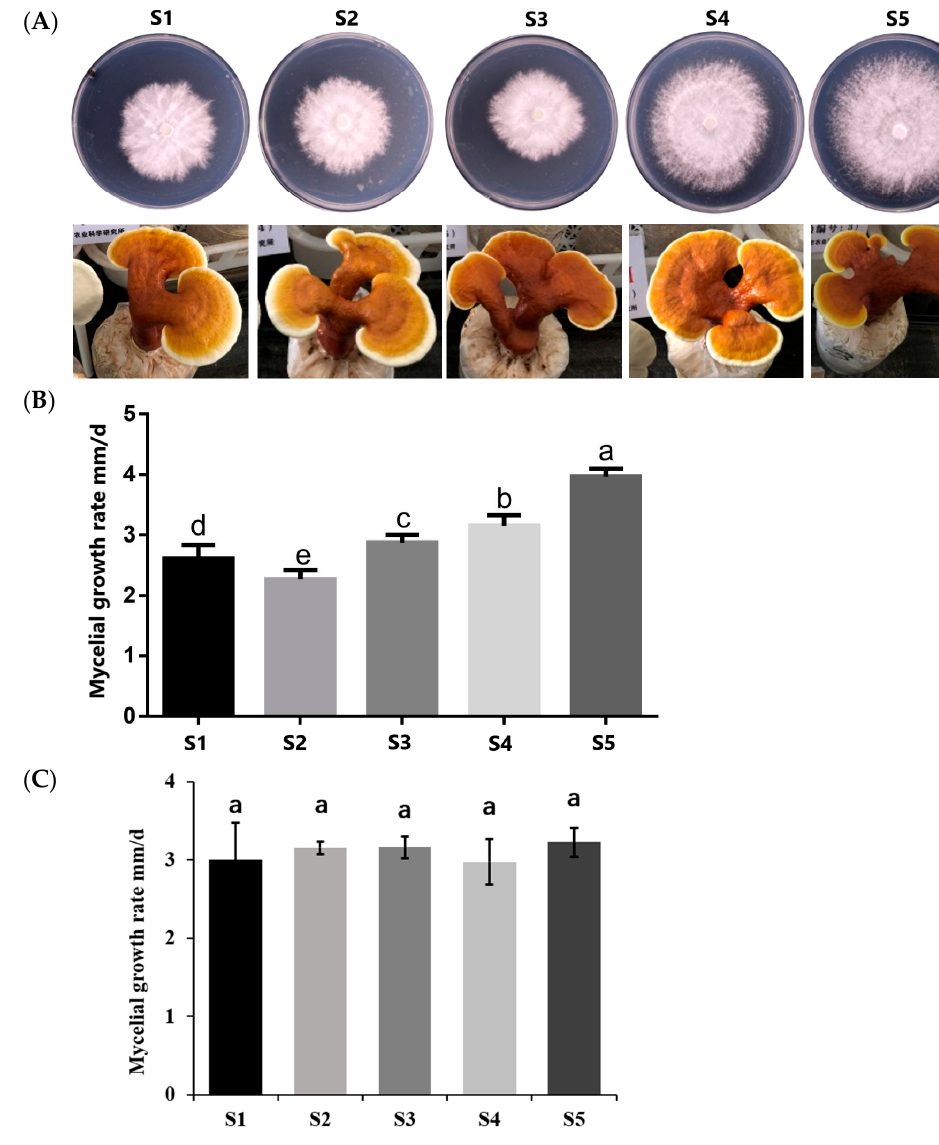
Figure 3. Biological characteristics of five isonuclear alloplasmic strains. ( A ) Colony and fruit body morphology. ( B ) Mycelial growth rate in PDA. Different lowercase a, b, c, and d indicate the significant difference among strains at the significance level of 0.05 ( p < 0.05). ( C ) Mycelial growth rate in solid-state fermentation. The same lowercase a indicates no significant difference among strains at the significance level of 0.05 ( p > 0.05).